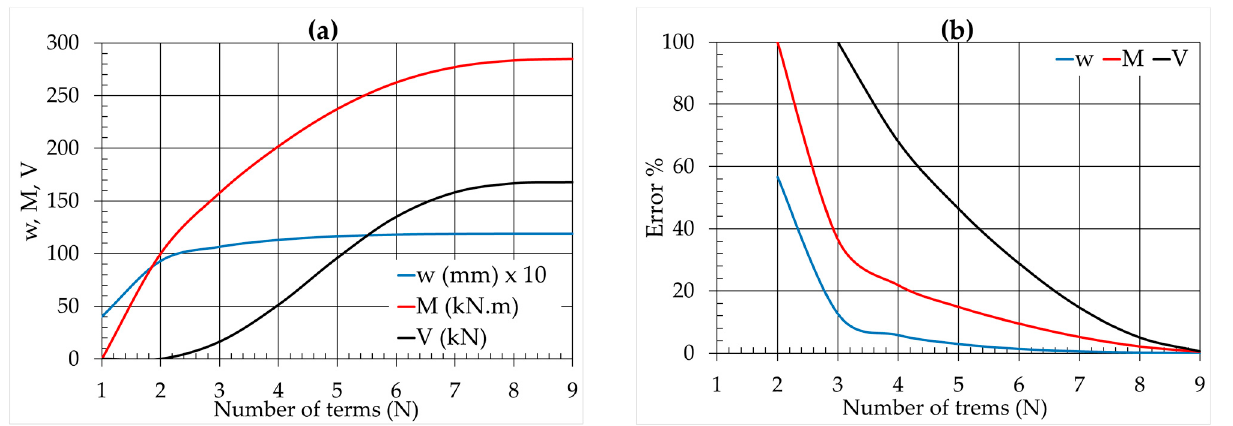
Figure 13. The convergence of the deflection, bending moment, and shear force at middle of the beam ( a ) values and ( b ) percentage errors.